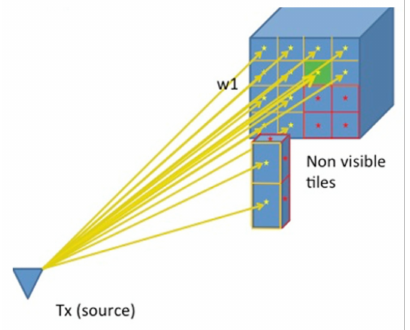
Figure 1. Automatic ray splitting using discrete ray